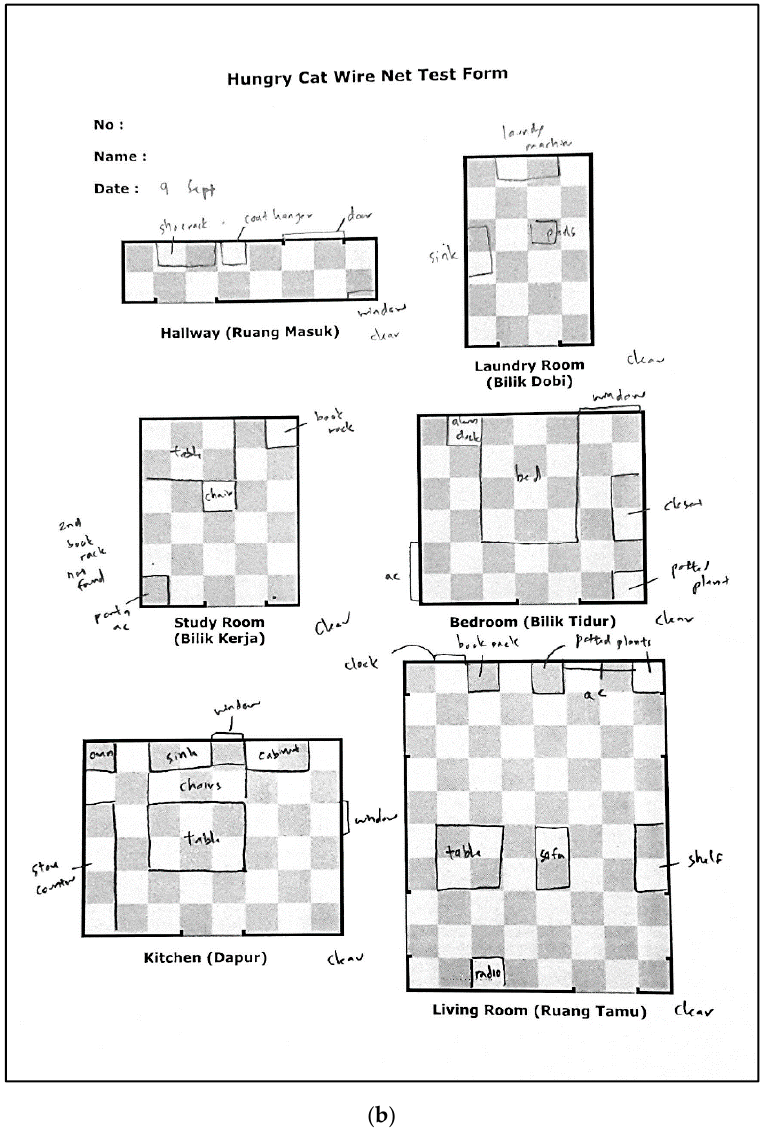
Figure 6. Wire net test result recording form: ( a ) empty form; and ( b ) scan of filled in form sample from evaluation (name censored for privacy).